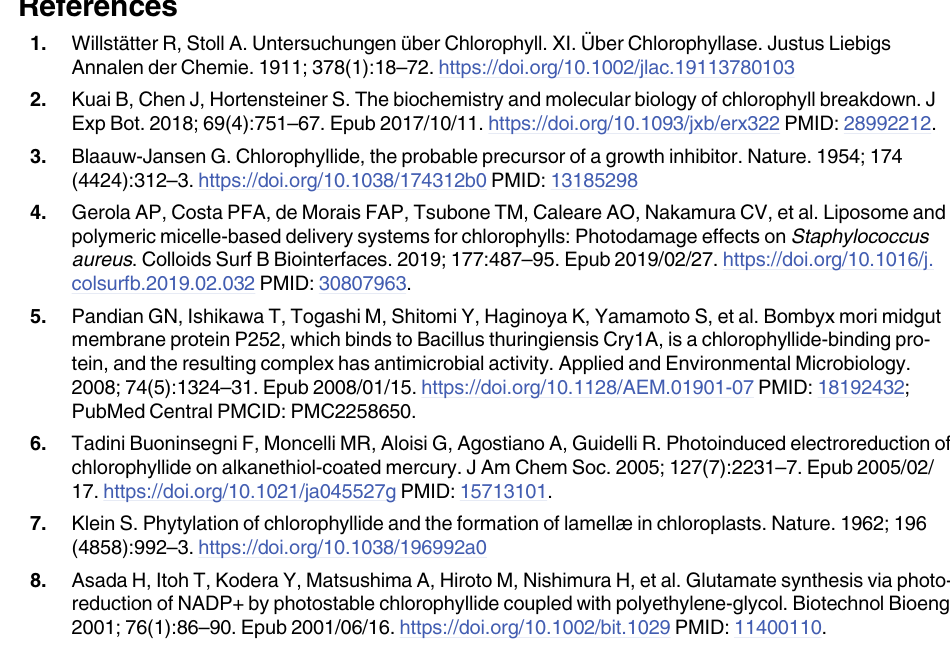
S1 Fig. MTT assay of (A) chlorophyllides in MCF7 cell lines, (B) chlorophyllides in MDA-MB-231 cell lines, (C) the combination of doxorubicin (0.625 μ g/mL) and chlorophyl- lides in the MDA-MB-231 cell lines. The statistical method used in this article is one way ANOVA using SigmaPlot Version 14.0. S1 Table. MS data from the purified